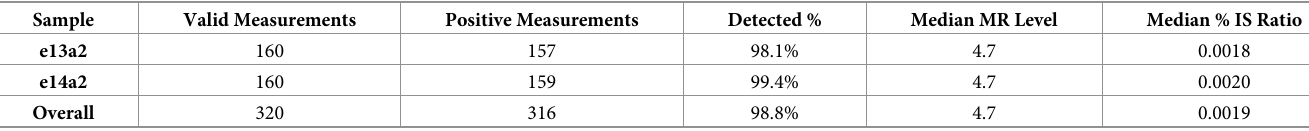
Fig 1. LOD by Probit. A Probit regression analysis was performed using a generalized linear model using a binomial family (solid line through the filled circles that are the median value for the 20 individual replicates). The LOD was calculated by interpolating the IS ratio that corresponds to a 95% detection rate shown as the thin, solid black horizontal and vertical lines. https://doi.org/10.1371/journal.pone.0265278.g001 precision metrics for MR, including within-run, between run, between operator, between lot and between instruments are displayed for patient and cell line control samples in [S3 Table]. ddPCR demonstrated acceptable precision for all test samples. Within-run variance was the largest contributor to the total precision metric and followed a Poisson distribution; kit lot, operator, instrument, and day having negligible impact on the variability of test samples. The maximum %CV for total precision between MR 0.3-MR4 (actual MR0.7-MR4.1) was 3.95%. Mean MR values were within 0.5 log of the target concentration for all samples, ranging from 0.47 MR (MR 2) to 0.05 (MR 4.7). Variation due to different extraction methods was not included in the total precision study. Table 1. LOD verification result summary.